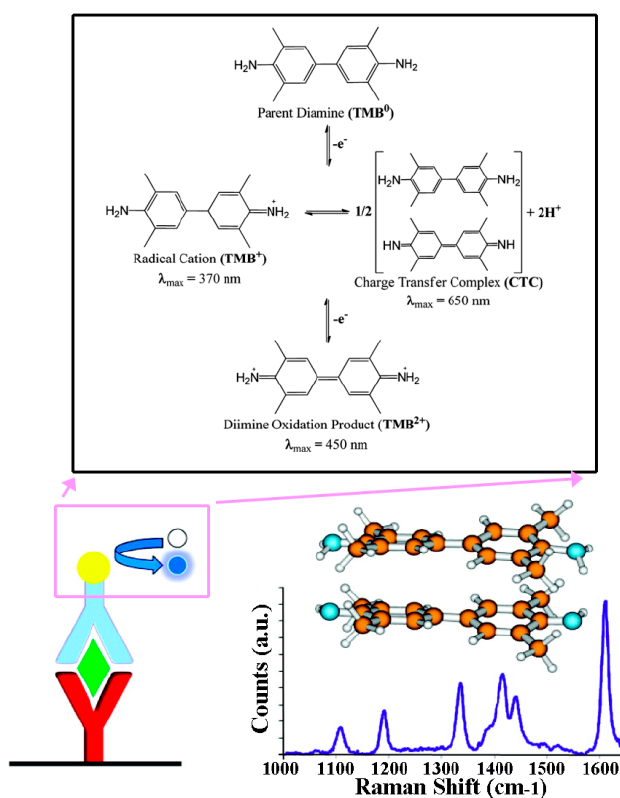
Figure 2. In a sandwich immunoassay involving HRP (yellow sphere)-labelled TNF- α antibody, the concentration of TNF- α analyte protein can be measured by examining the characteristic peaks for the oxidized products (indicated as blue sphere) of the TMB substrate (indicated as white sphere) whose conversion is triggered by HRP in the presence of H 2 O 2 . Reproduced with permission from Ref. [65] Copyright (2011) American Chemical Society.